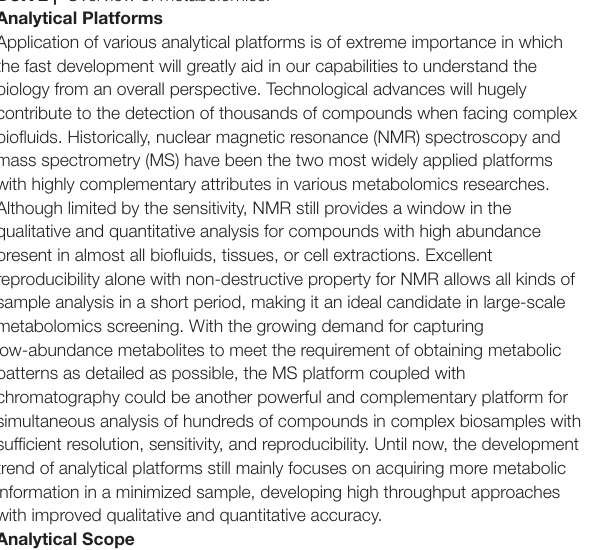
( Table 1 ), highlighting the promising applications and providing several suggestions for metabolomics